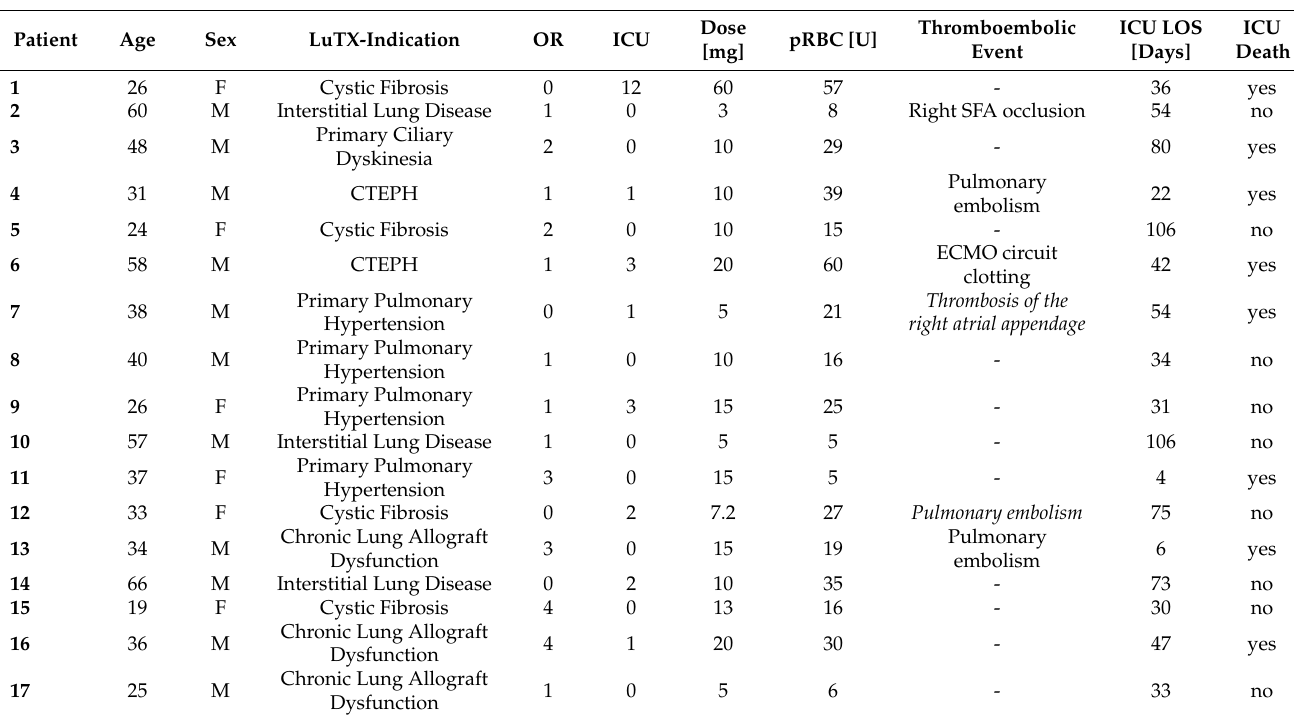
Table 2. Clinical data of individual cases. Each row lists baseline and outcome data of an individual patient. The number of administered doses of rFVIIa in the ICU and OR as well as the cumulative dose are shown alongside the number of pRBC units transfused during ECMO therapy. Thromboembolic events occurring >5 days after the first dose of rFVIIa are printed in italics . ECMO = extracorporeal membrane oxygenation; LuTX = lung transplantation; OR = Operating room; ICU = intensive care unit; rFVIIa = recombinant, activated Factor VII; mg = milligram; pRBC = packed red blood cells; U = unit; LOS = length of stay; M = male; F = female; CTEPH = chronic thromboembolic pulmonary hypertension; SFA = superior femoral artery.